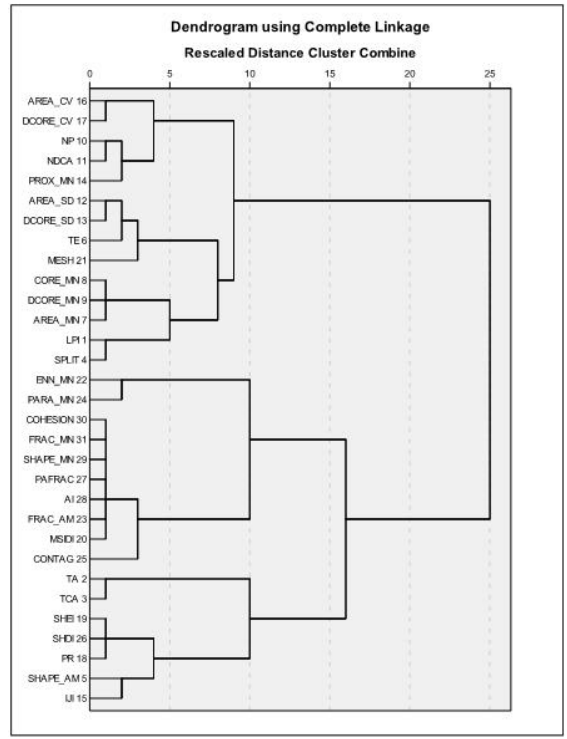
Figure 3. Dendrogram of the hierarchal clustering of metrics.